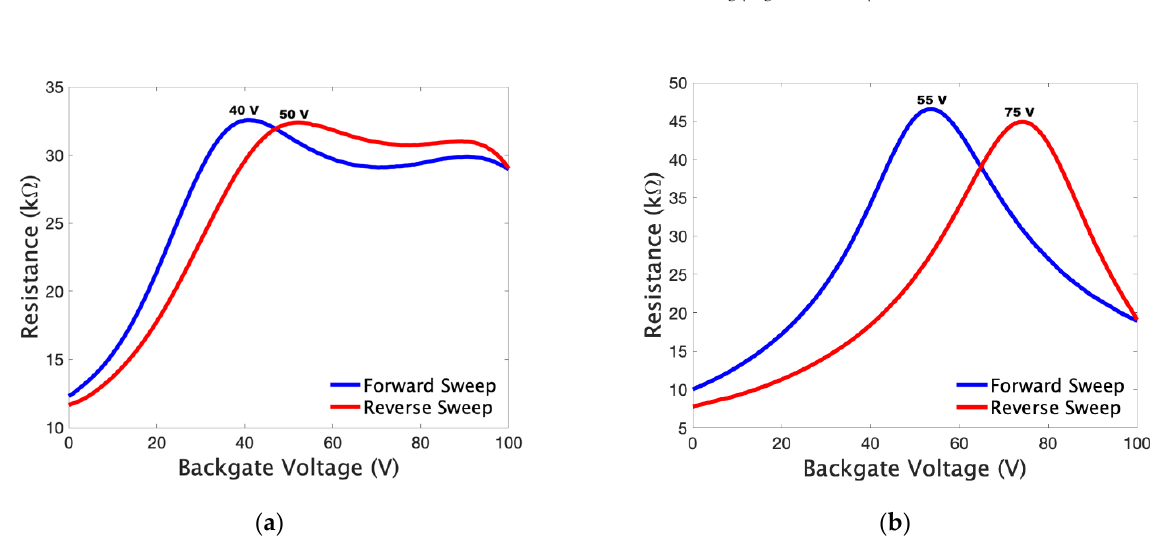
Figure 5. Backgate sweeps to locate the charge neutrality point for ( a ) graphene on SiO 2 and ( b ) graphene on hBN/SiO 2 .